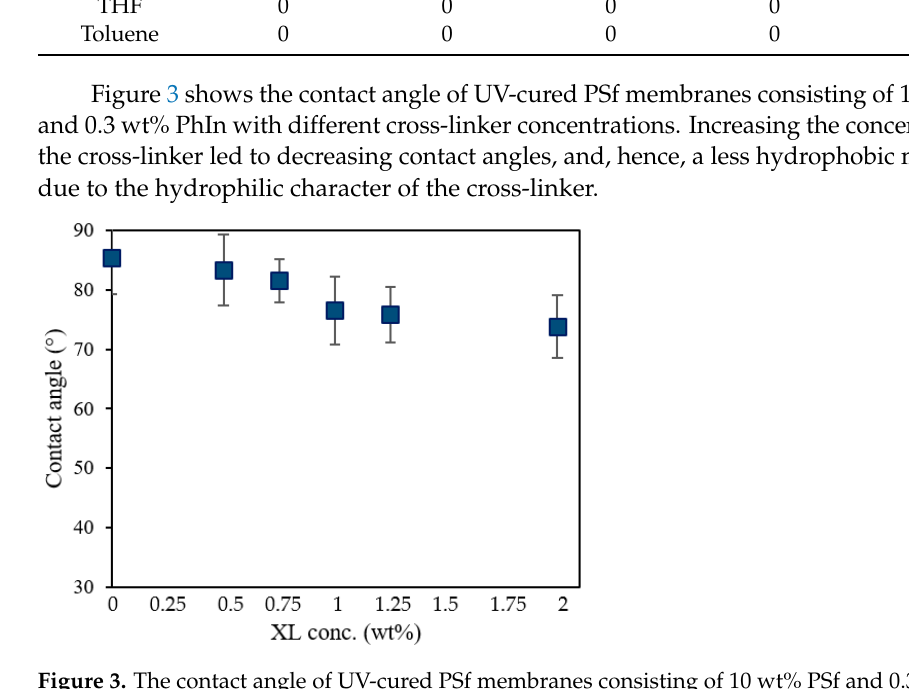
Figure 3. The contact angle of UV-cured PSf membranes consisting of 10 wt% PSf and 0.3 wt% PhIn with different cross-linker concentrations.